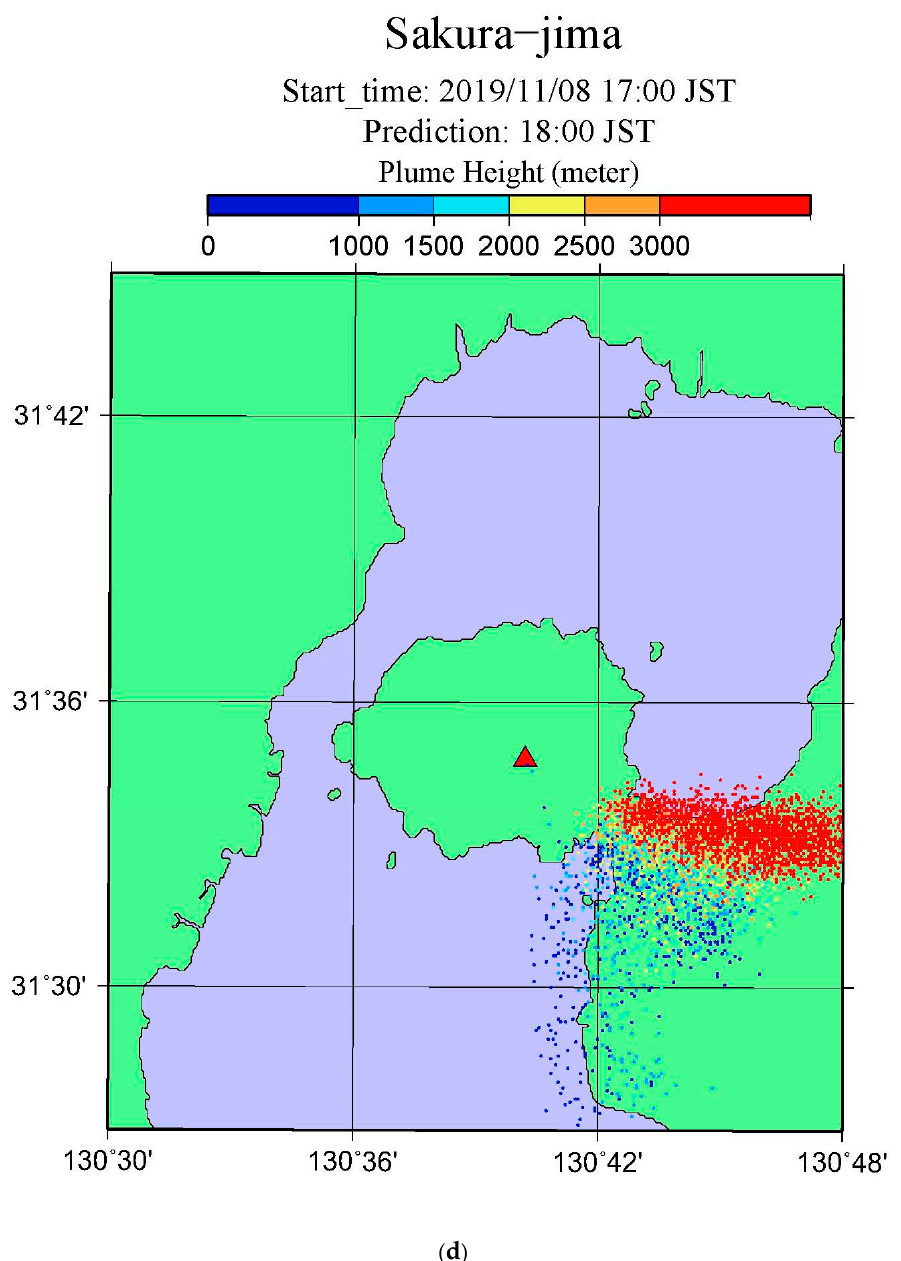
Figure 3. The PUFF model simulation of the horizontal ash plume dispersal for ( a ) 17:30, ( b ) 17:40, ( c ) 17:50, and ( d ) 18:00 JST, respectively. The particle colors indicate di ff erent plume heights. Figure 4 plots longitude-height (X-Z) and meridional-height (Y-Z) cross sections of ash plume dispersal for (a) 17:30, (b) 17:40, (c) 17:50, and (d) 18:00 JST, respectively. The colors of particles indicate a di ff erent plume height. At 17:30, the ash plume reached 4000 m a.s.l indicating wider spread in the X-Z plot drifted by the westerly wind. In the Y-Z plot, the plume shows no drift indicating a narrow vertical column. Part of the low-level particles below 1500 m moves faster to south. The eruption continued about 20 min, and terminated by 17:50. By analyzing the series of the plots, it is clear that the ash plume moved to the southwest of the volcano.